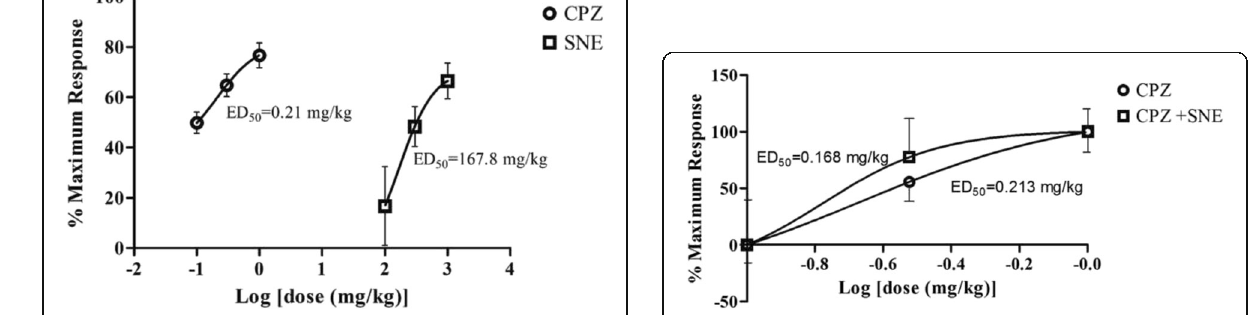
Fig. 7 A dose-response effect of CPZ (0.1 – 1 mg/kg) alone and CPZ (0.1 – 1 mg/kg) + SNE 100 mg/kg against apomorphine-induced stereotypy behaviour in mice. Data are mean ± SEM ( n =